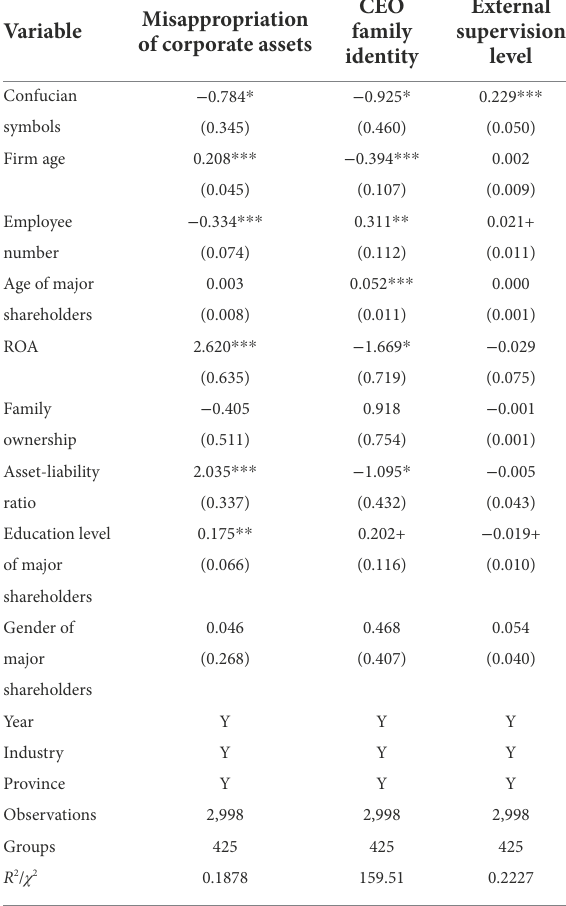
TABLE 7 Results of combining three measurement methods of the Confucian